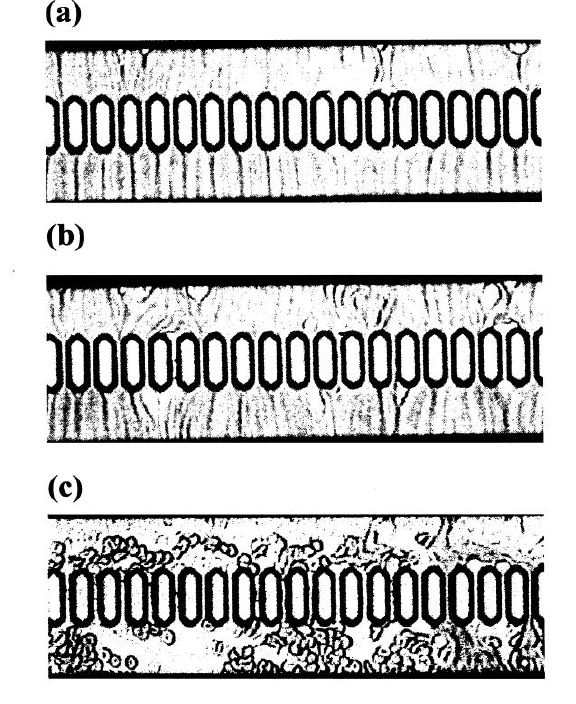
Figure 7. Microscopic details of blood samples passing through individual micro-channel array of the MC-FAN. (a) View of temperature-untreated sample with transit time = 12.6 s and transit sample volume = 25 μL. (b) Identical temperature-untreated with transit time = 27.8 s and transit sample volume = 50 μL. (c) View of identical blood sample to that in a and b, but subjected to mild heating at 45 °C for 30 min prior to application to MC-FAN, with a transit time = 120.7 s and transit sample volume = 30